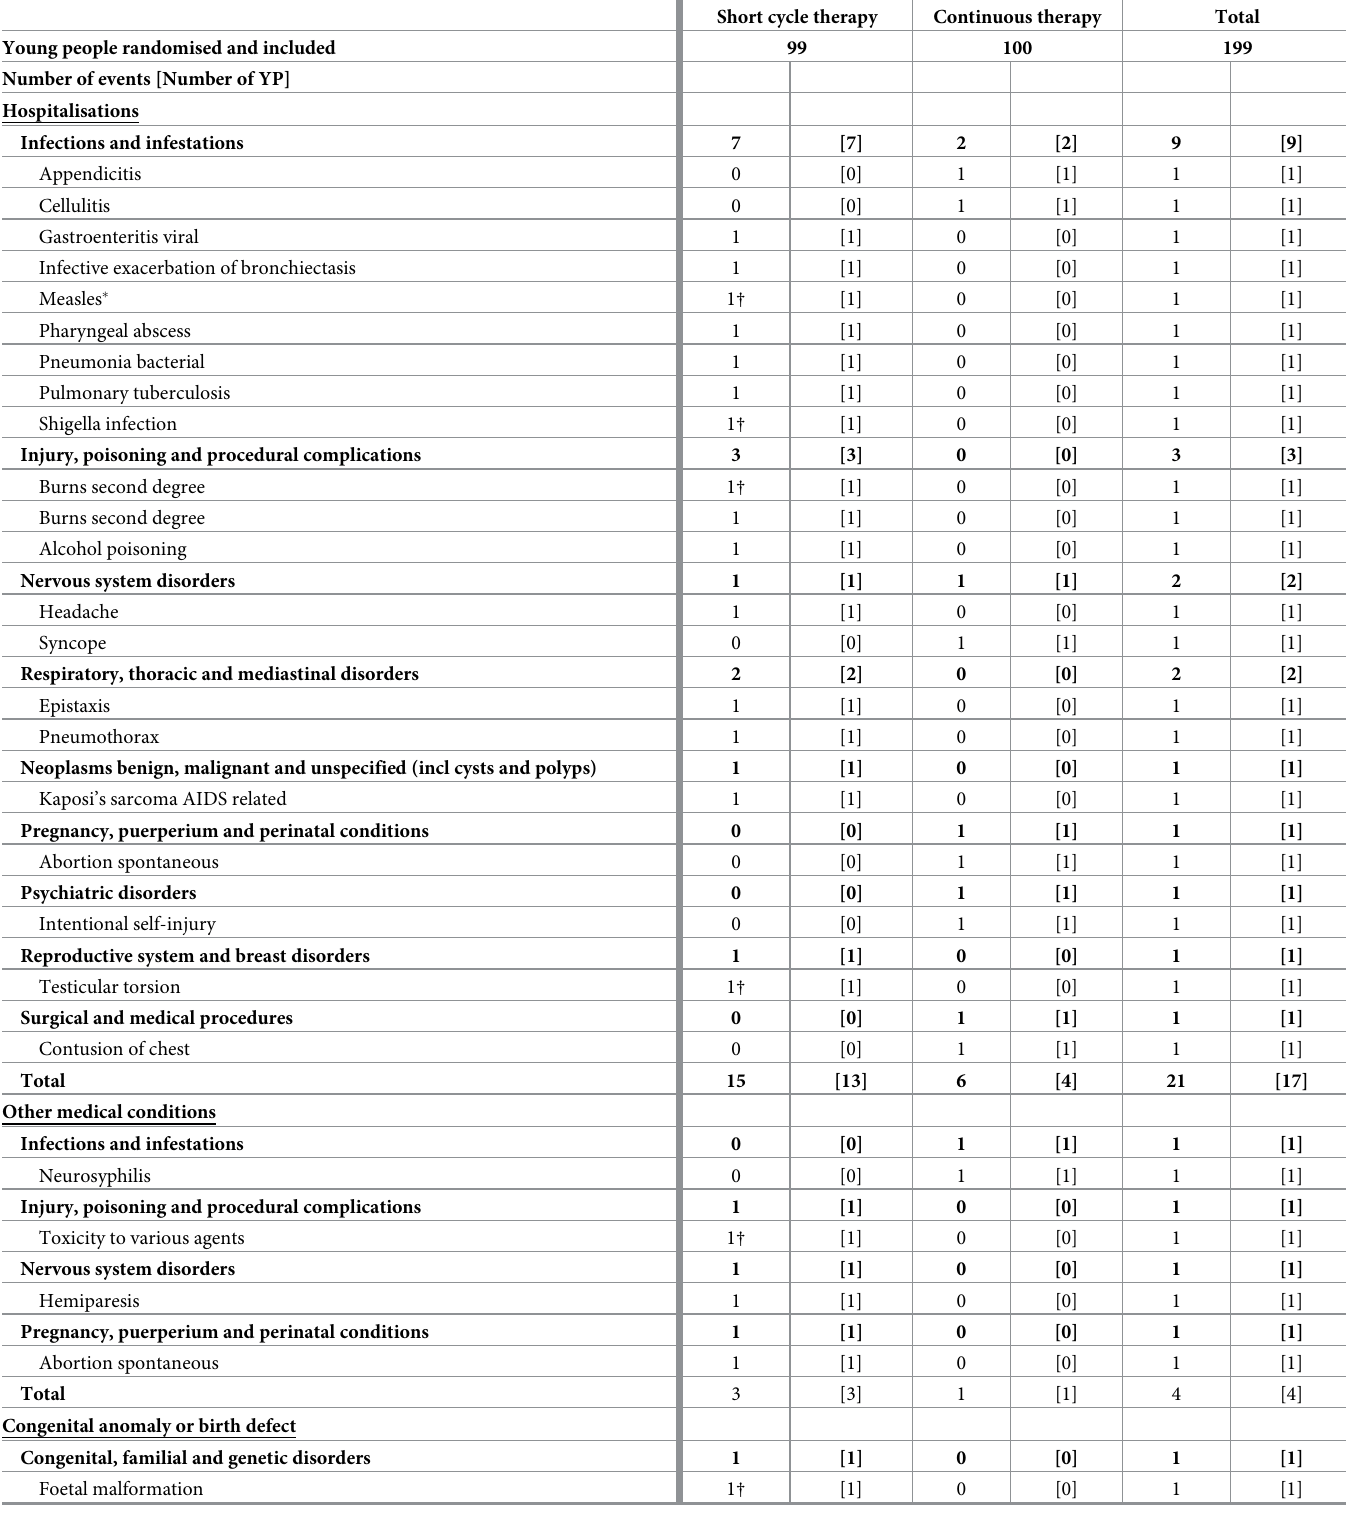
Table 5. Details of serious adverse